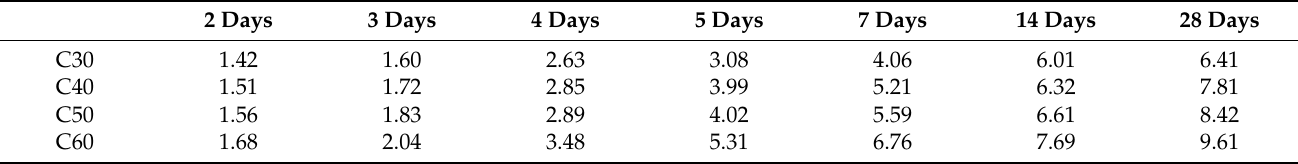
Table 7. Capillary tension on concrete at four ages